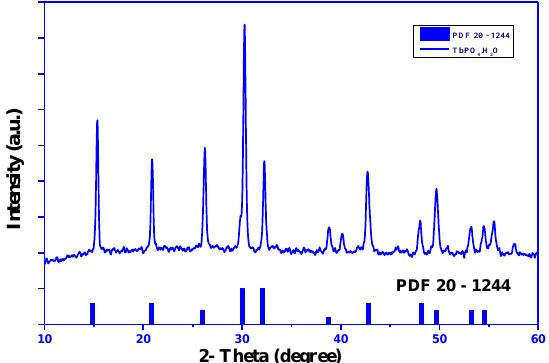
Figure 2. The X-ray diagram of Terbium phosphate monohydrate hexagonal crystals determined using an X-ray di ff raction measuring system (Siemens D5000 with λ = 1.5406 Å, di ff raction angle in the range of 15 ◦ ≤ 2 θ ≤ 75 ◦